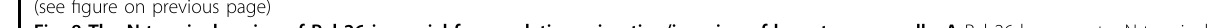
Fig. 8 The N-terminal region of Rab26 is crucial for regulating migration/invasion of breast cancer cells. A Rab26 has an extra N-terminal extension in amino-acid sequence compared with other Rab proteins. B Wound-healing assays showed over-expression of Rab26b (which does not contain the N-terminal extension) did not inhibit migration of MDA-MB-231 cells. C Quantitative analysis of the wound area using imageJ software from three independent wound-healing experiments, * p < 0.05. D Matrigel transwell invasion assay showed over-expression of Rab26b does not inhibit invasion of MDA-MB-231 cells. E Quantitative analysis of C from three independent experiments, * p < 0.05. F Double-layer soft-agar experiments showed that over-expression of Rab26b does not inhibit colony formation of MDA-MB-231 cells in soft agar. G Rab26b does not interact with ATG16L1 in GST pull-down assay. H GFP-Rab26b is distributed in cytosol, not associating with mCherry-ATG16L1 in MDA-MB-231 cells, bar = 20 μ m. I Rab26b does not induce the degradation of phosphorylated Src in western-blot experiments. J Quantitative analysis of the results of I from three independent experiments, * p < 0.05. K A model for Rab26 inhibiting cell migration/invasion through mediating autophagic degradation of phosphorylated Src. In this model, Rab26 associates with endosomes and recruits ATG16L1 to generate autophagophore, and subsequent LC3 to autophagosomal isolate membrane, LC3 then recruits the active Src (p-Src). After autophagosome maturation, it fuses with lysosome to degrade p-Src. The degradation of the active Src may inhibit formation or turnover of focal adhesion, consequently inhibiting cell migration and